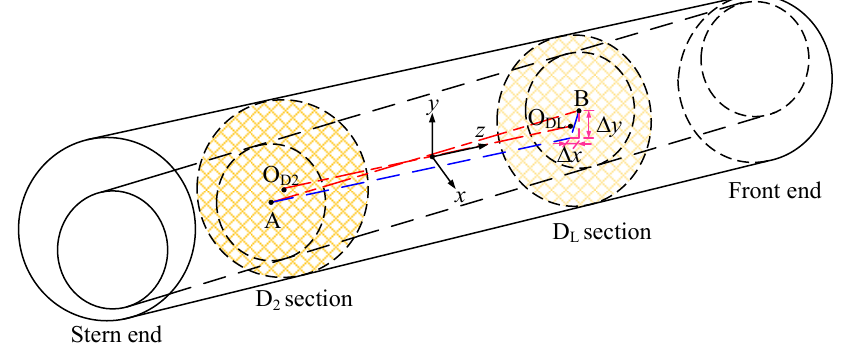
Figure 6. Three ‐ dimensional schematic of bi ‐ directional bearing tilt. Figure 6. Three-dimensional schematic of bi-directional bearing